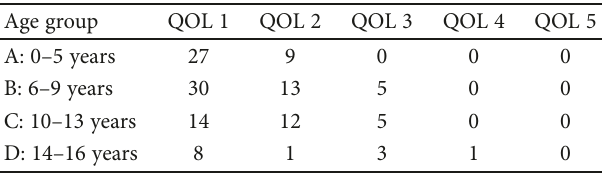
Figure 2: Quality of life (QOL) score for di ff erent age groups of dogs receiving single injection of MSCs by an IA injection. Table 5: IA injection and quality of life score with respect to the age groups.